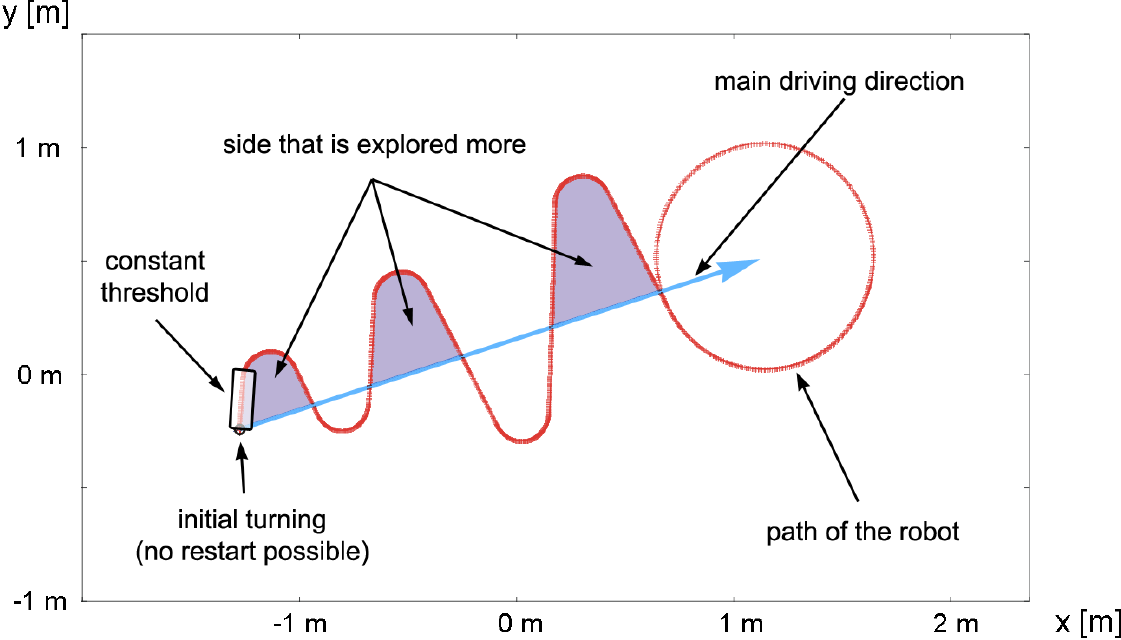
Figure 20 . Gas source tracing strategy based on the behaviour of Bombyx mori males, and adapted for the condition that no information about air currents is available. The figure shows the fixed motion pattern, which is executed in response to an increased gas